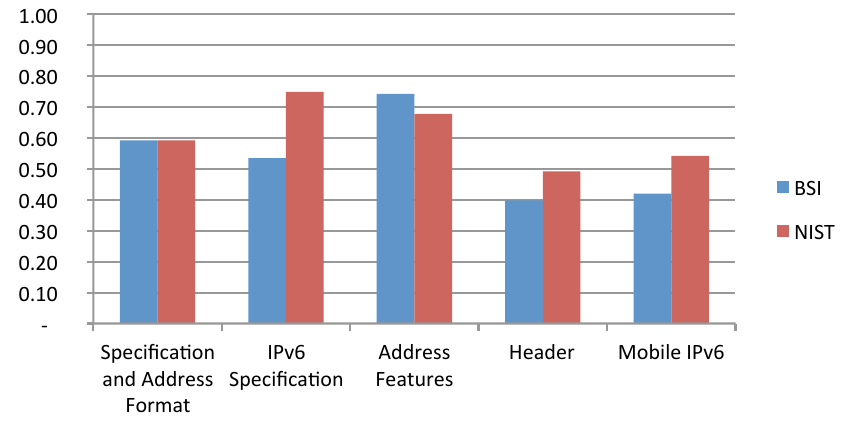
Figure 9. Average depth of IPv6 specification and address